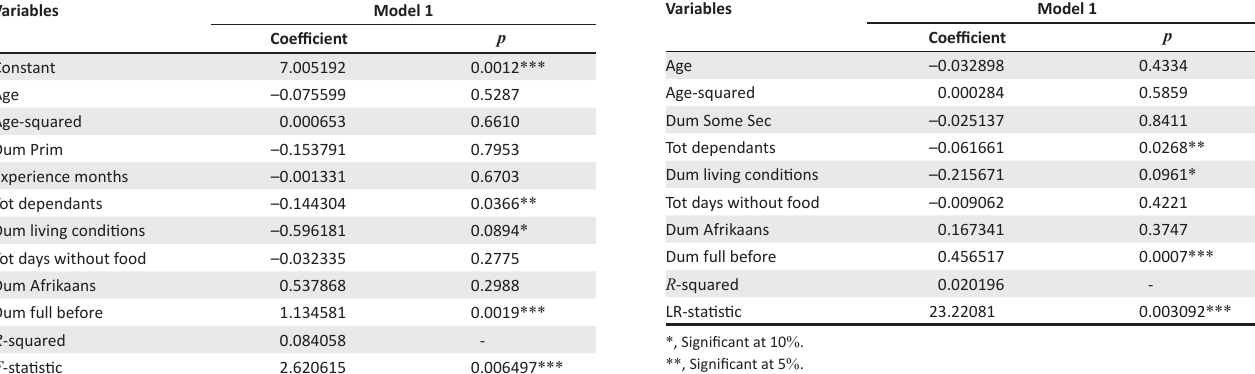
TABLE 4: Pretoria day labourers’ subjective well-being regression 1 results. TABLE 5: Pretoria ordered-probit analysis